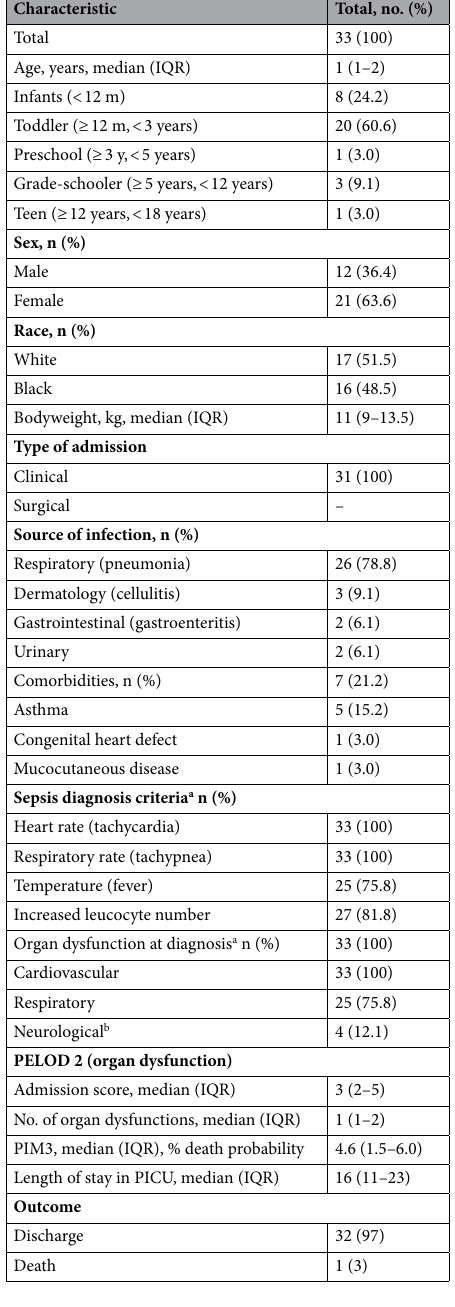
Table 1. Demographics, epidemiological, and clinical features of patients with sepsis, evaluated for possible diagnosis of sepsis-associated encephalopathy. IQR interquartile range, PELOD 2 Pediatric